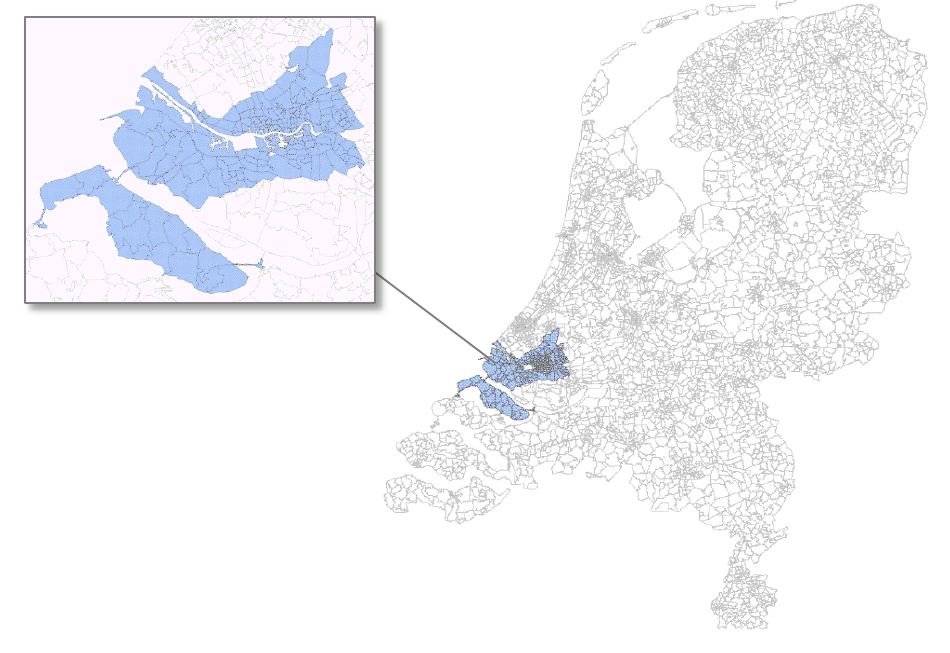
Figure 1. The Rijnmond